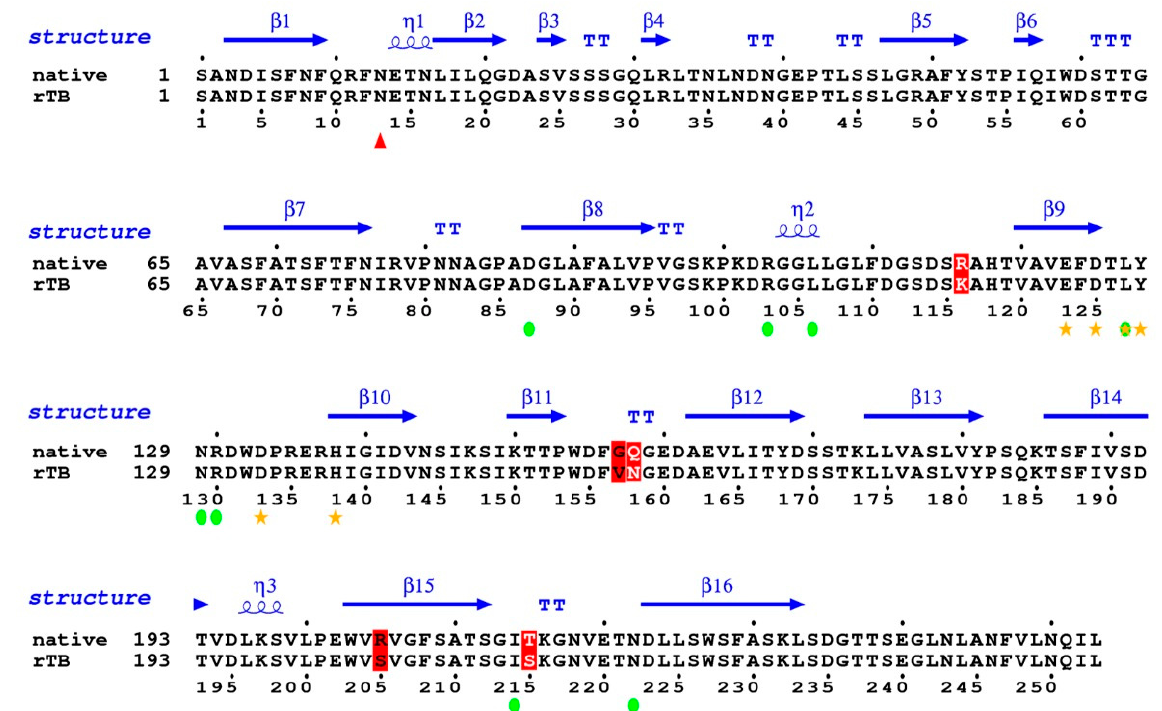
Figure 6. Coverage percentage of identity between the mature sequences of rTBL-1 and the Tepary bean native lectin. Sequences were analyzed by ESPript Versi ó n 3.0 (Lyon, France) (http://espript.ibcp.fr/ESPript/ESPript/ last access on February 2021). Red triangle shows the glycosylation site; yellow stars show amino acids involved in metal coordination; green circles show the carbohydrate binding site. Changes are shown in red color.